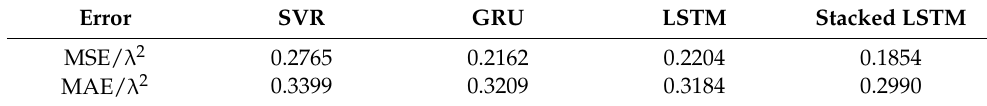
Table 2. Mean square error and mean absolute error of power on different